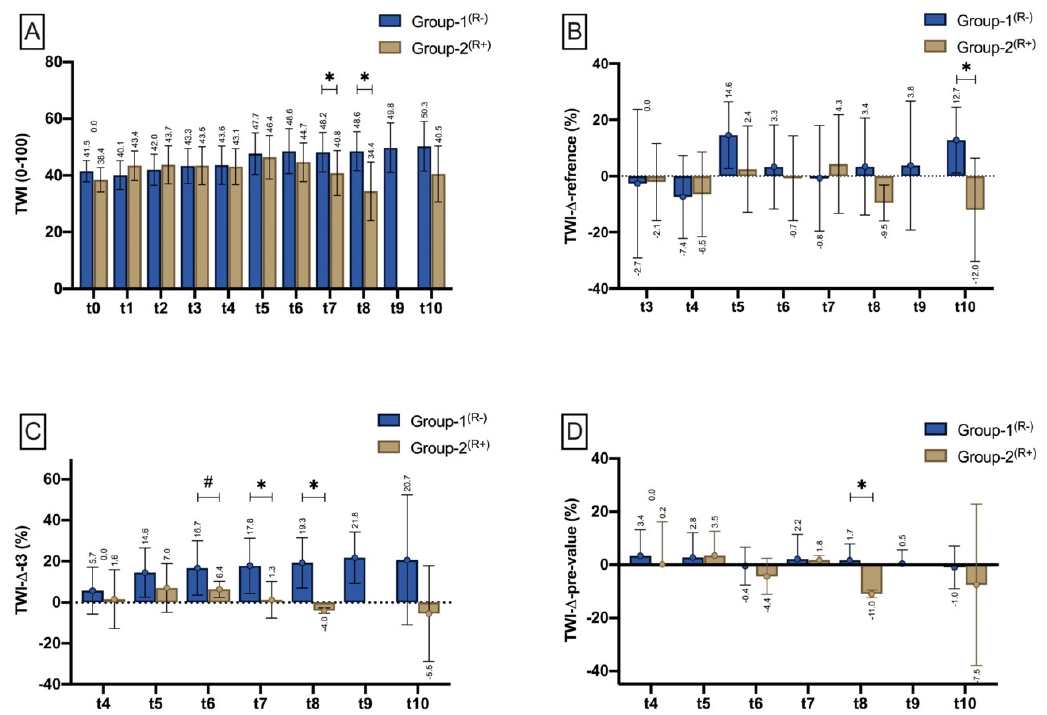
Figure 7. Bar chart with means ( ± SD) show TWI at different measurement timepoints (t0–t3)/time intervals (t4–t10) as ( A ) (TWI mean), ( B ) TWI drop to reference (%) TWI drop to the respective reference site (TWI ∆ reference), ( C ) TWI drop to t3 (TWI Δ t3), and ( D ) in relation to the pre-measurement (TWI Δ pre-value). Means are shown scalar. Asterisk (*) marks existing significance. ANOVA (#).